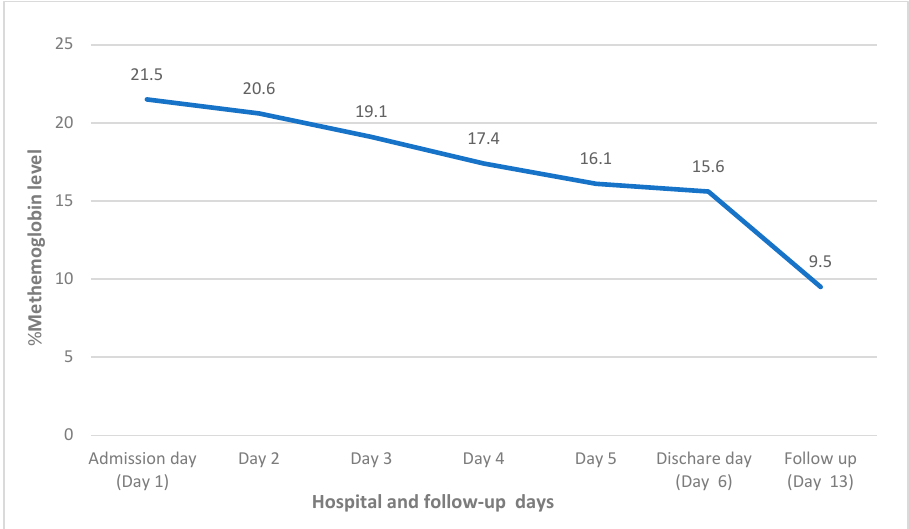
Clin. Pract. 2022 , 12, FOR PEER REVIEW Figure 1. The trend of methemoglobin levels during the hospitalization and follow-up.